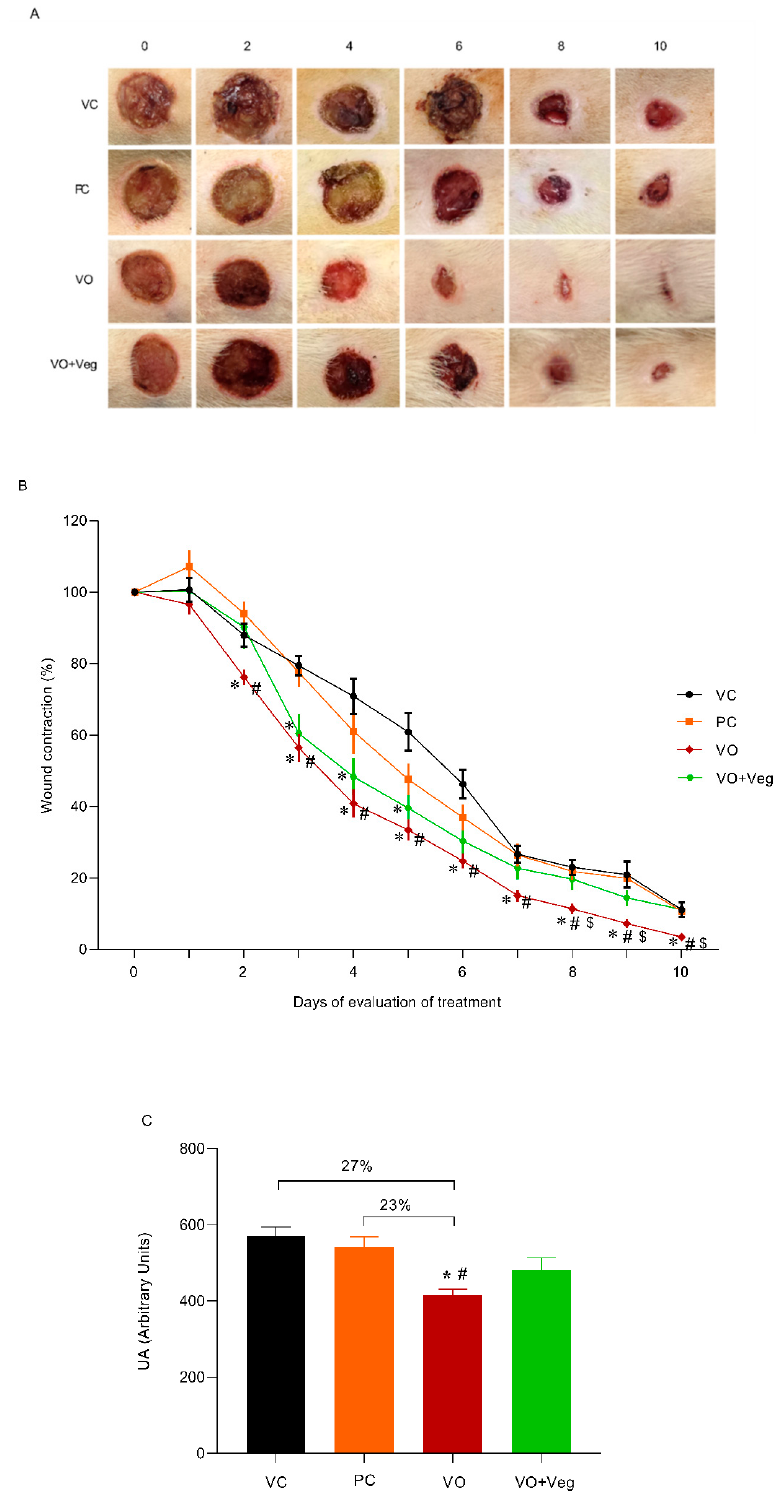
Figure 3. ( A ) Representative photographs of the wound by group and treatment evaluation time (0 until 10th day). ( B ) Quantitative analysis of wound contraction after daily topical use of vehicle control (VC), positive control Dersani ® (PC), Virola oleifera (VO), and Virola oleifera with Vegederm (VO + Veg) for 10 days. ( C ) Area under the curve of the experimental groups representing healing effect between groups. The data are expressed as mean ± SEM; * p < 0.05: VO vs. VC; # p < 0.05: VO vs. PC, and $ p < 0.05: VO vs. VO + Veg.